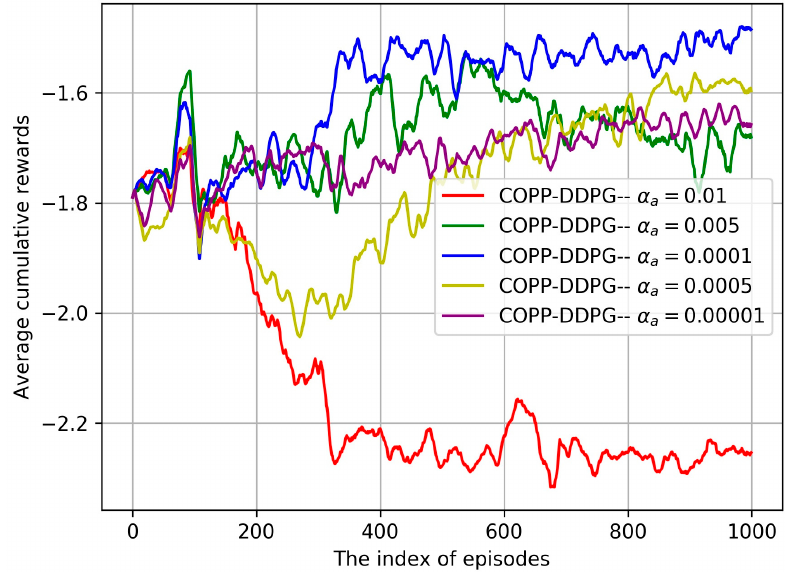
Figure 3. Convergence of COPP-DDPG with different actor learning rates α a .